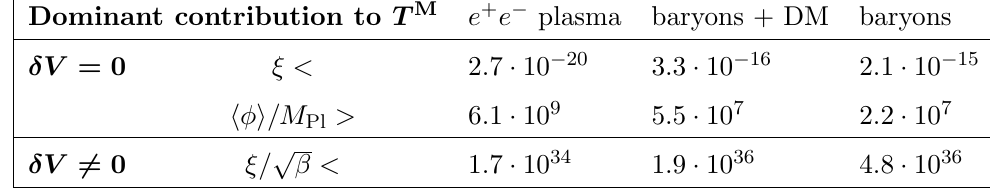
Table 1 . Experimental constraints on the evolution of Planck mass from Big Bang Nucleosynthesis. For the one-(cid:12)eld scale-invariant case ( (cid:14)V = 0), those set upper bounds on the non-minimal coupling (cid:24) and lower bounds on the scalar (cid:12)eld h (cid:30) i , depending on which matter component makes the dominant contribution to the r.h.s. of eq. (2.6). If the scale invariance is broken by quantum e(cid:11)ects p ( (cid:14)V 6 = 0), we derive upper bounds on the ratio (cid:24)= (cid:12) , where (cid:12) is the (cid:12) -function of the